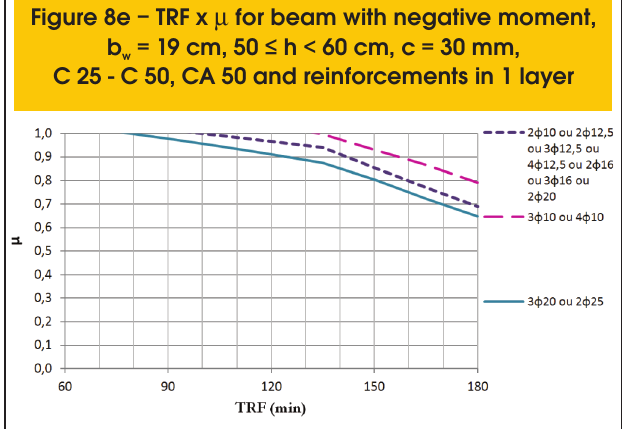
Figure 8h – TRF x m for beam with negative moment, b = 19 cm, h ≥ 60 cm, c = 30 mm, C 25 - C 50, w